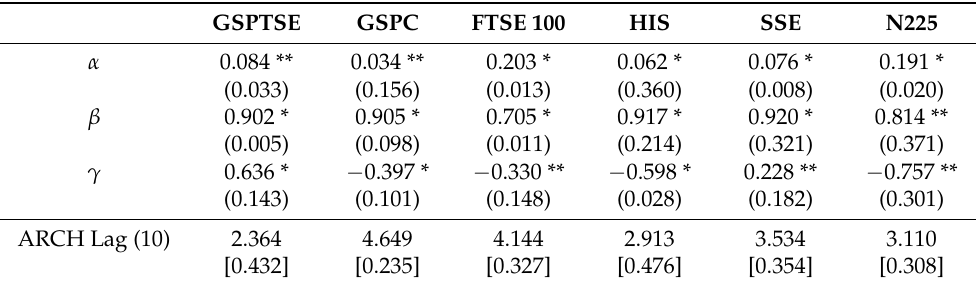
Table 2. Estimation results of the single-equation models for the stock market indices under consid- eration after the COVID-19 outbreak started.